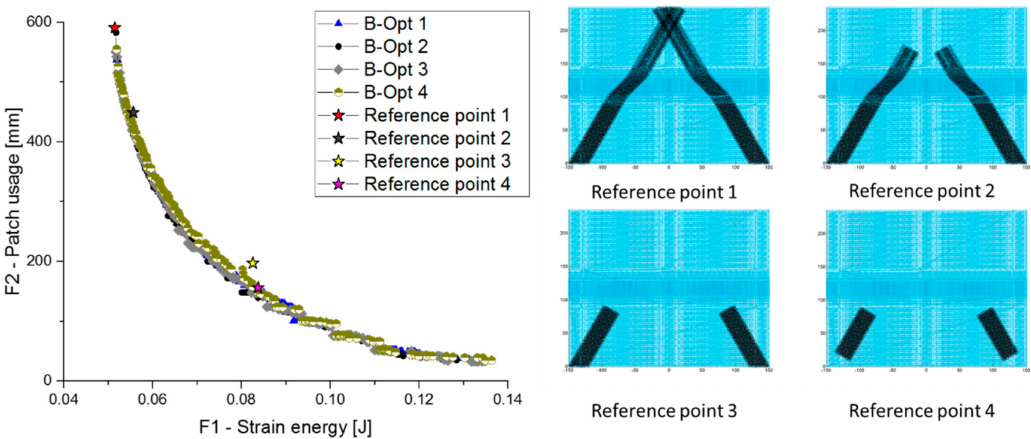
Figure 12. Comparison of the Pareto fronts obtained for the curved structure, and predefined reference points to classify the results.